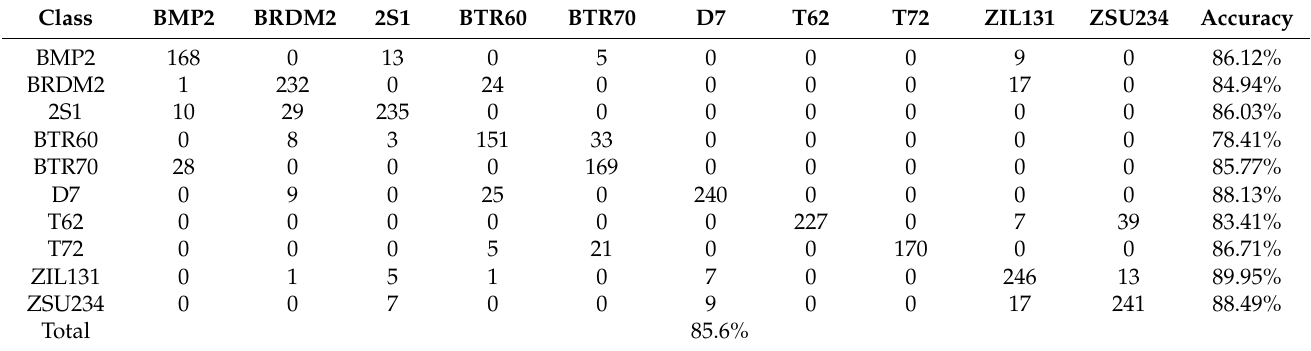
Table 4. Confusion matrix of testing results of the ADMF-FCNN model trained on subset-20.